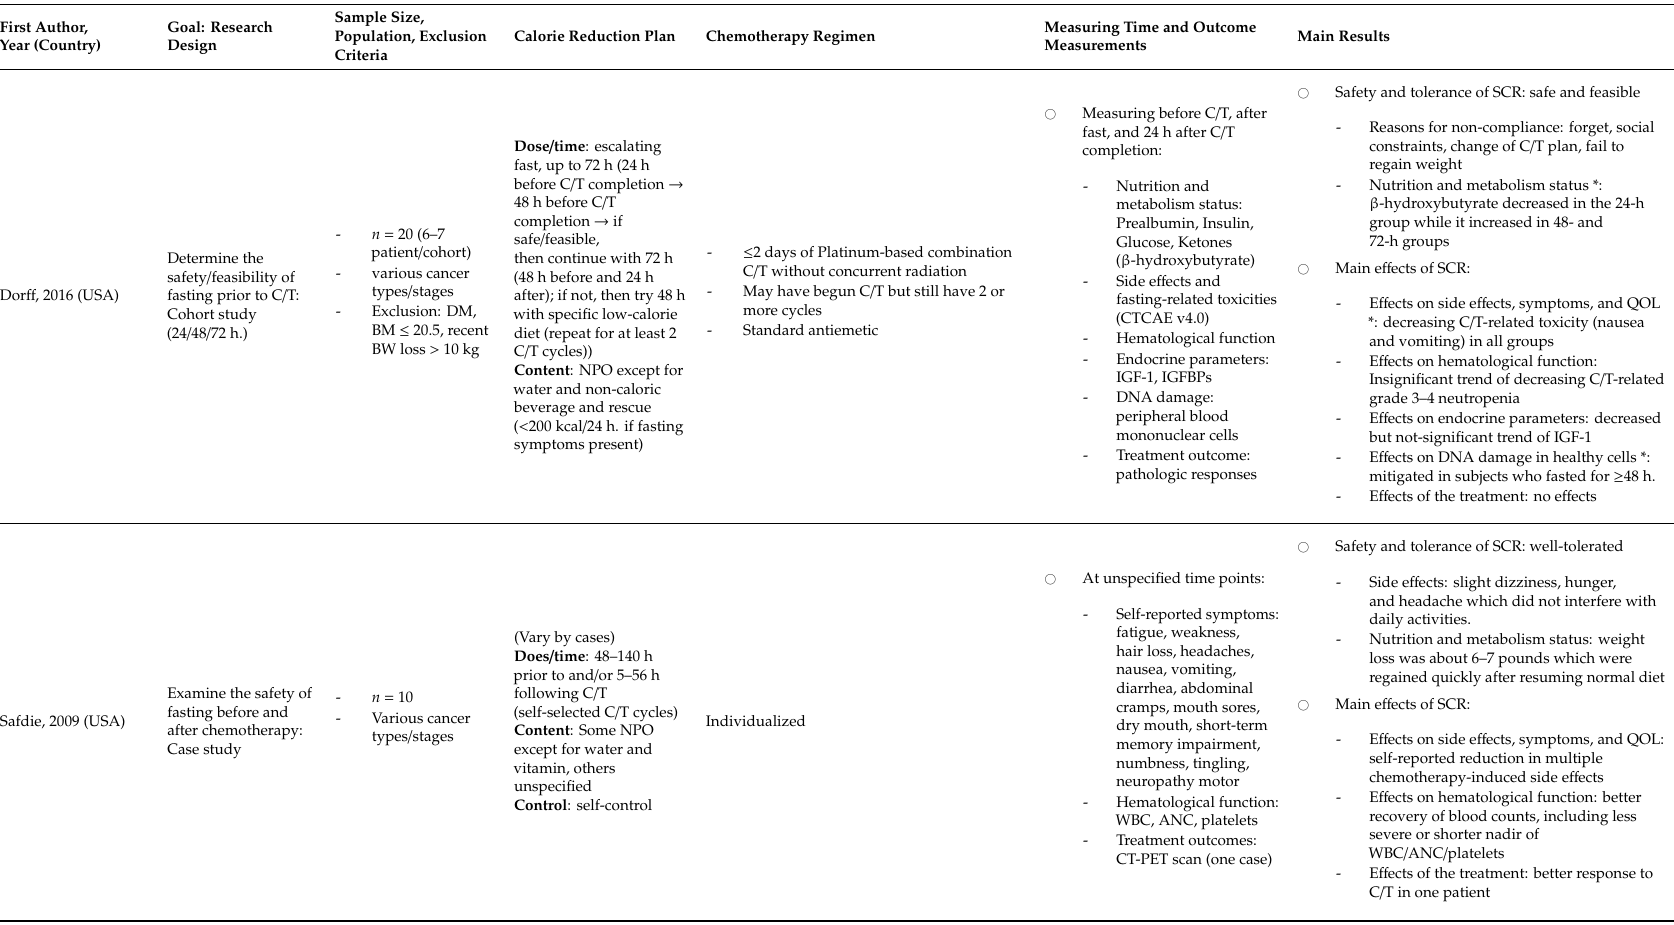
Table 3. Information of Reviewed Articles: Type of Design, Method, and Maine